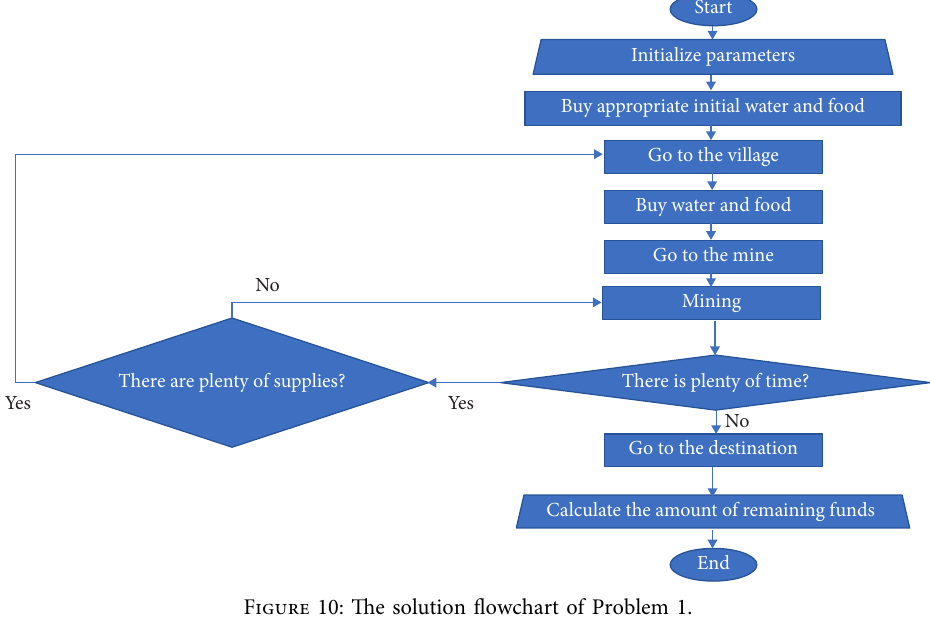
Figure 10: The solution flowchart of Problem 1.